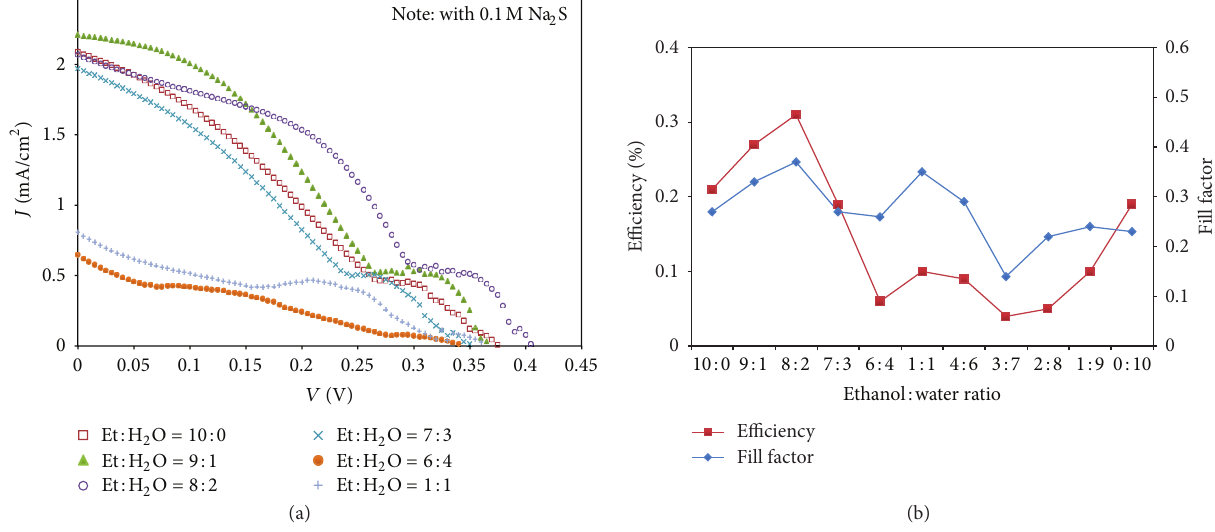
Figure 1: (a) 𝐽 - 𝑉 curves of CdSe QDSSCs with 0.1M Na 2 S electrolyte having various solvent ratio. (b) Variation of efficiency and fill factor of the cells with different solvent ratio in the electrolyte. Table 1: Performance parameters of CdSe QDSSCs with 0.1M Na Solution composition of the